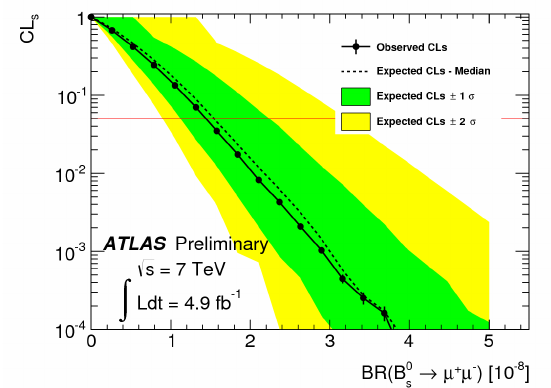
Figure 11: Observed confidence levels (CLs, circles) are shown as a function of BR( B 0 s → μ + μ − ). The 95% CL limit is indicated by the horizontal (red) line. The green and yellow bands correspond to ± 1 σ and ± 2 σ fluctuations on the expectation (dashed